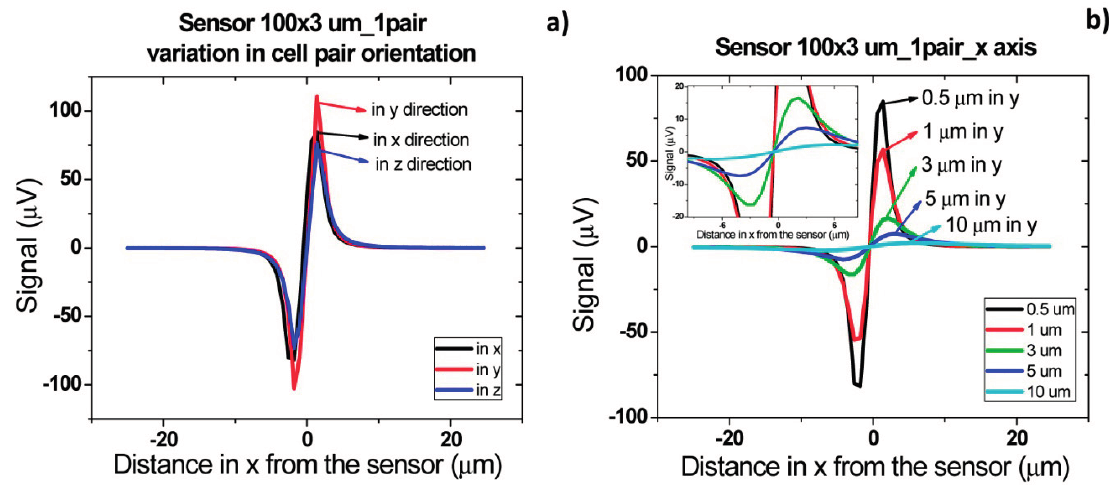
Figure 15. Signal simulation for Streptococcus agalactiae . ( a ) Pair of cells oriented according with each axis; ( b ) Signal variation with height from the sensor according with x